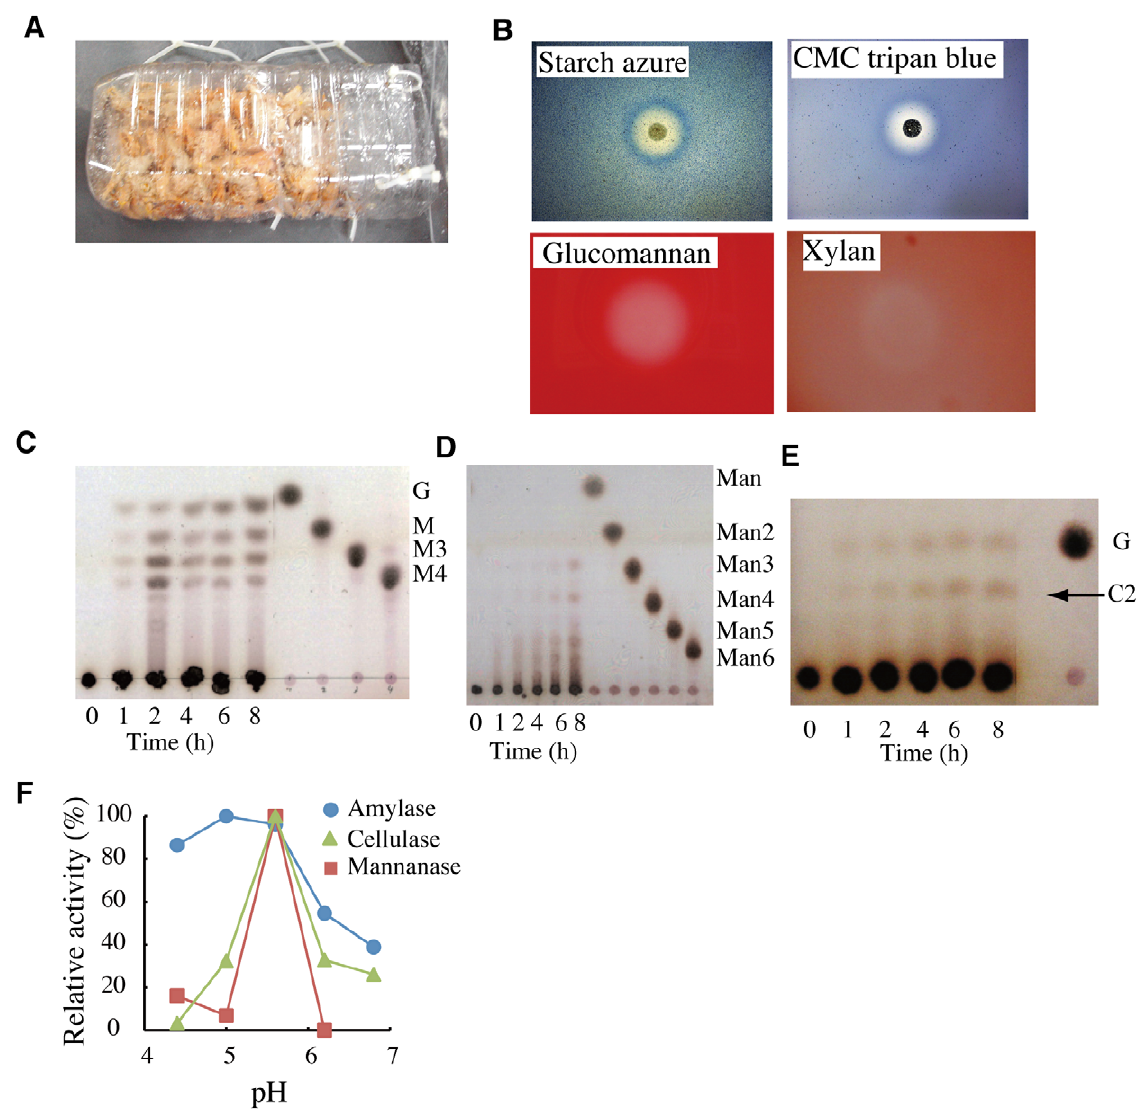
Figure 1. H . gigas possesses polysaccharide hydrolase activities. We captured deep-sea animals using baited traps containing a slice of mackerel. One baited trap contained approximately 50 individuals (A). Digestive enzyme activities were assessed by halo formation in agar plates containing starch azure (amylase), CMC and trypan blue (cellulase), glucomannan (mannanase), and xylan (xylanase). The halos produced by the amylase and cellulase activities were visualized directly, while the halos resulting from mannanase and xylanase were detected after staining with 0.5% Congo red followed by washing with DDW (B). The kinetics of the reactions were determined by TLC as described in the Methods section of this paper. Reactions with crushed H . gigas with 0.5% (w/v) starch (C), 0.2% (w/v) glucomannan (E) or 1% (w/v) CMC (D) were conducted in 100 mM sodium acetate buffer (pH 5.6) at 30 u C. The pH dependencies of the amylase, mannanase, and cellulase activities were measured with protein extracts (F). The enzyme reactions were conducted in 100 mM sodium acetate buffer (pH 4.4–5.6) or 100 mM sodium phosphate buffer (pH 6.2–6.8). The relative activities are shown. doi:10.1371/journal.pone.0042727.g001 whether HGcel could digest wood. The data demonstrate that HGcel degraded wood to glucose at 35 u C (Fig. 3I). HGcel also produced glucose and cellobiose from sawdust and CMC at the same 2:1 molar ratio; the glucose produced from wood was approximately one-fifth of the amount generated from CMC. In addition, HGcel can produce glucose from plain paper at room temperature (Fig. S5). This enzymatic property of HGcel would help H. gigas to utilize various cellulosic materials in the oligotrophic environment as carbon sources. Furthermore, HGcel may be useful in the production of glucose from various cellulosic biomass sources to be used in bio-ethanol fermentation [35].